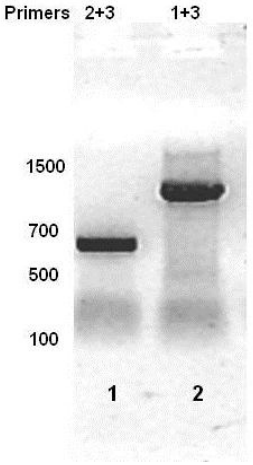
Figure 3. RT-PCR analysis of total bacterial RNA isolated from MG1655::λ imm434 lysogens. Total RNA was reverse transcribed using Primer 1 (see Figure 1). The cDNA was PCR separately amplified with primers 2 + 3 (lane 1) or 1 + 3 (lane 2), and products